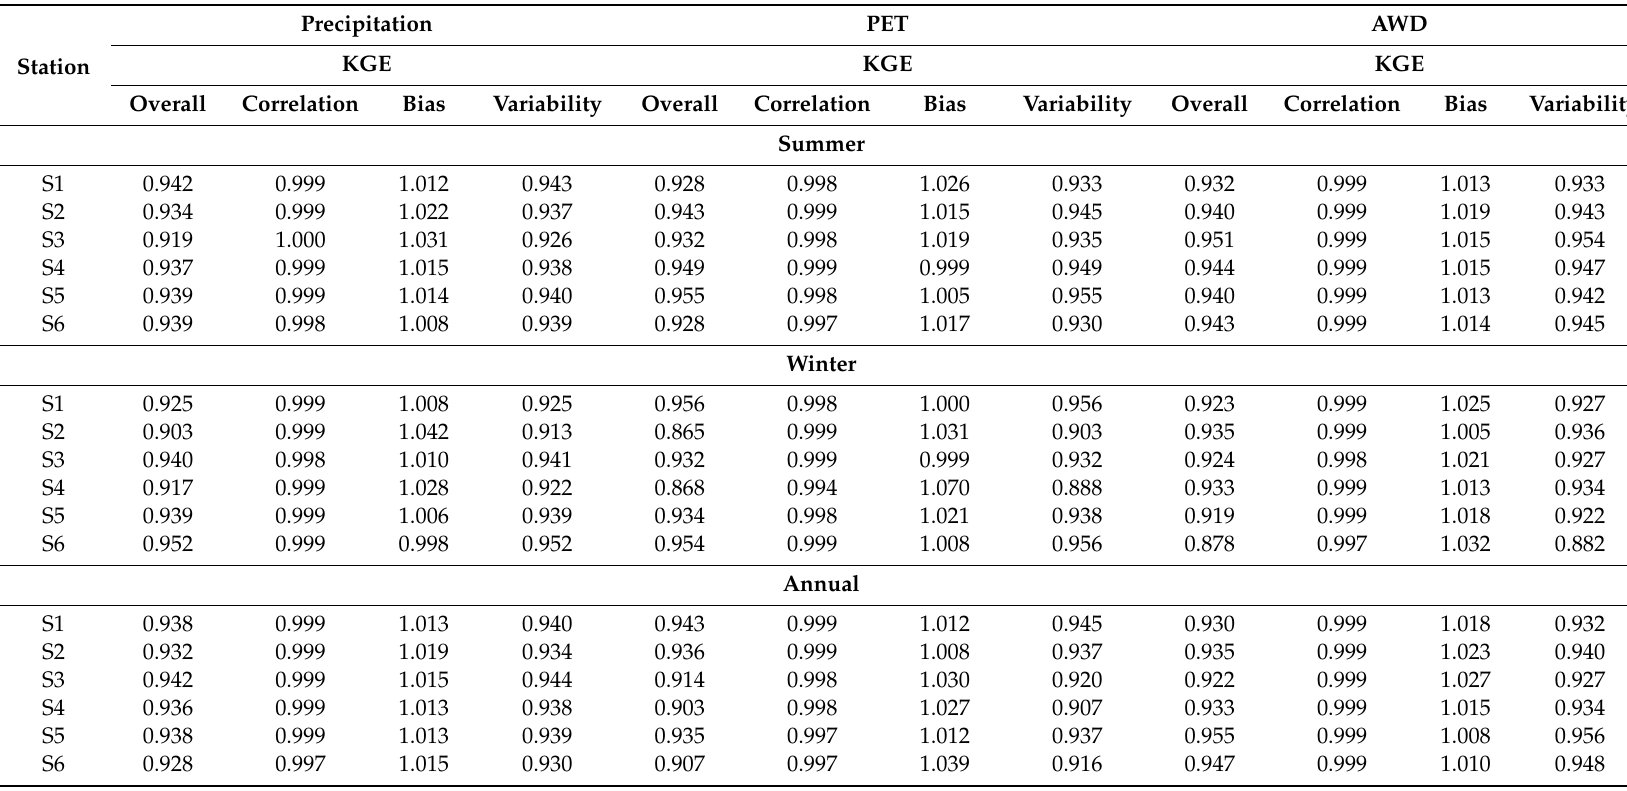
Table 3. Goodness of fit statistics for marginal distributions of meteorological fluxes at six representative stations across climate zones (see Figure 2b for the locations of stations and corresponding climate